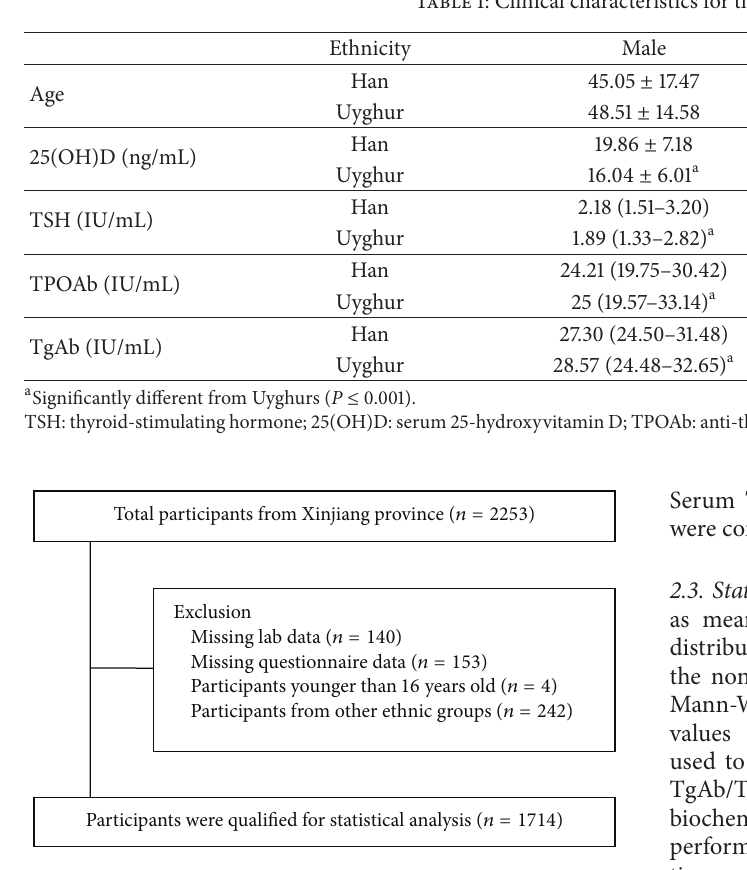
Figure 1: Flow diagram of participant enrollment in our